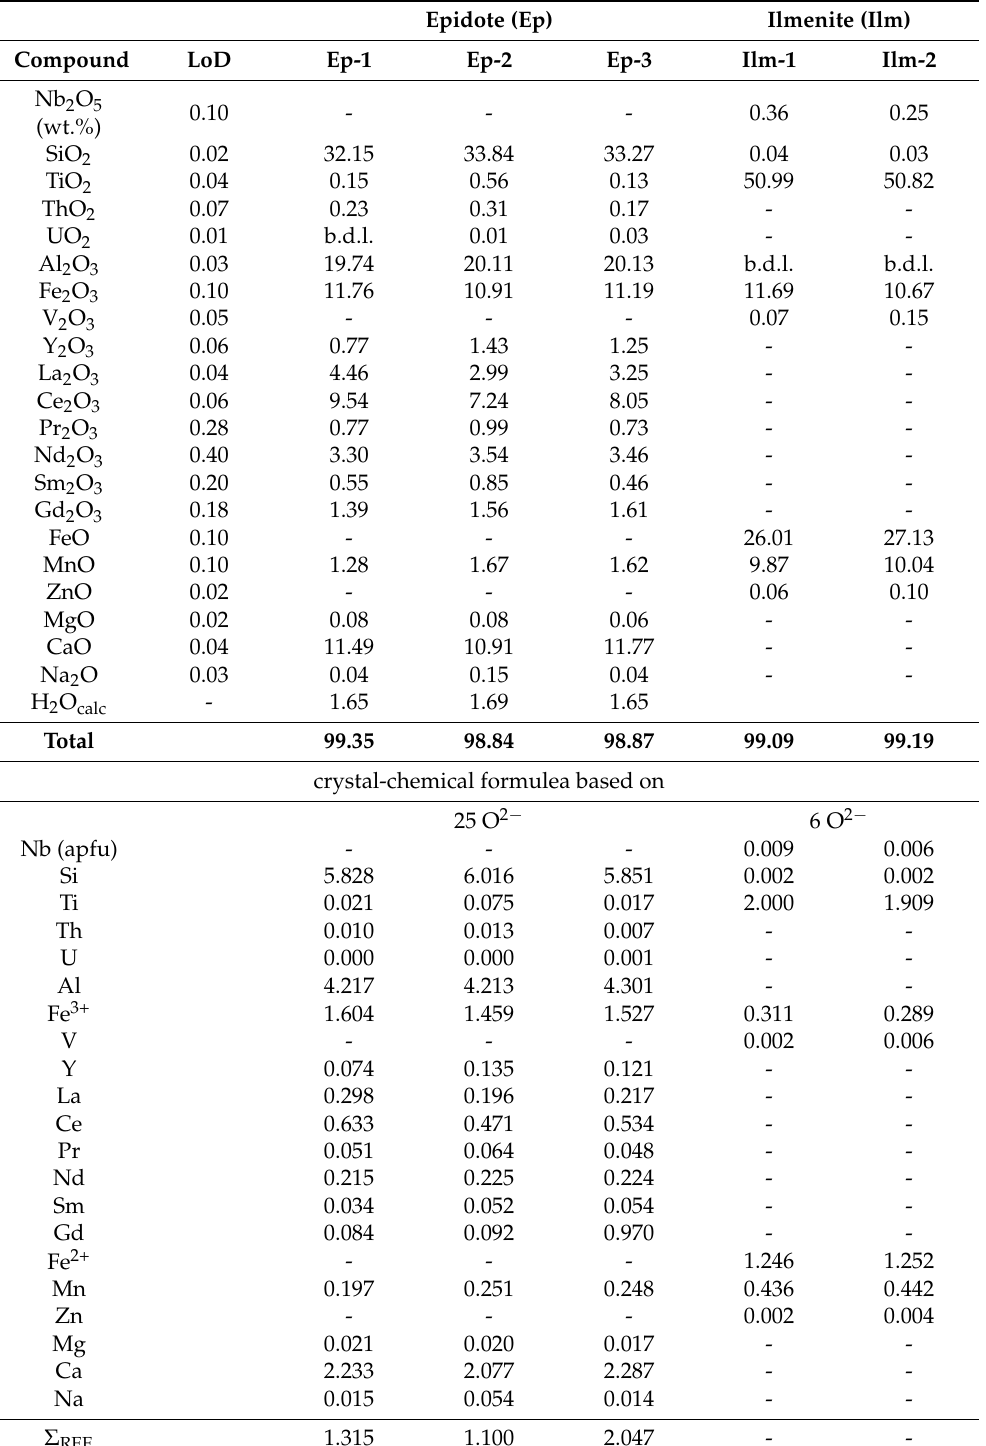
Table 2. Selected microchemical analyses and crystal chemical formulae of epidote and ilmenite from Pluskawka (Pl 2)